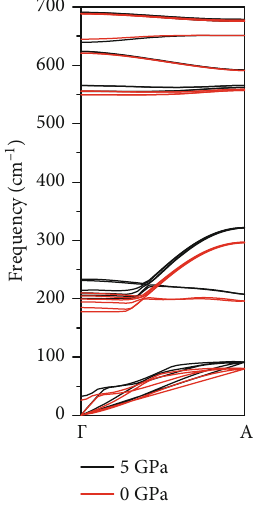
Figure 7: The phonon dispersion curve of orpiment As and 5 GPa